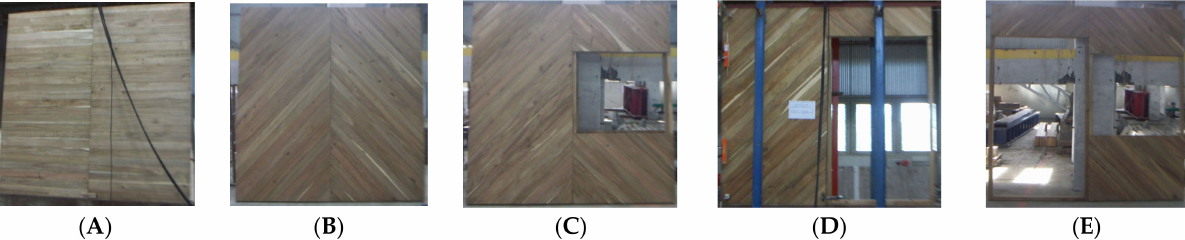
Figure 6. Types of shear wall components as the result of four assembly design patterns. ( A ) Shear wall in board pattern; ( B ) Diagonal sheathing wall; ( C ) Diagonal sheathing wall with windowed; ( D ) Diagonal sheathing wall with door; ( E ) Diagonal sheathing wall with windowed and